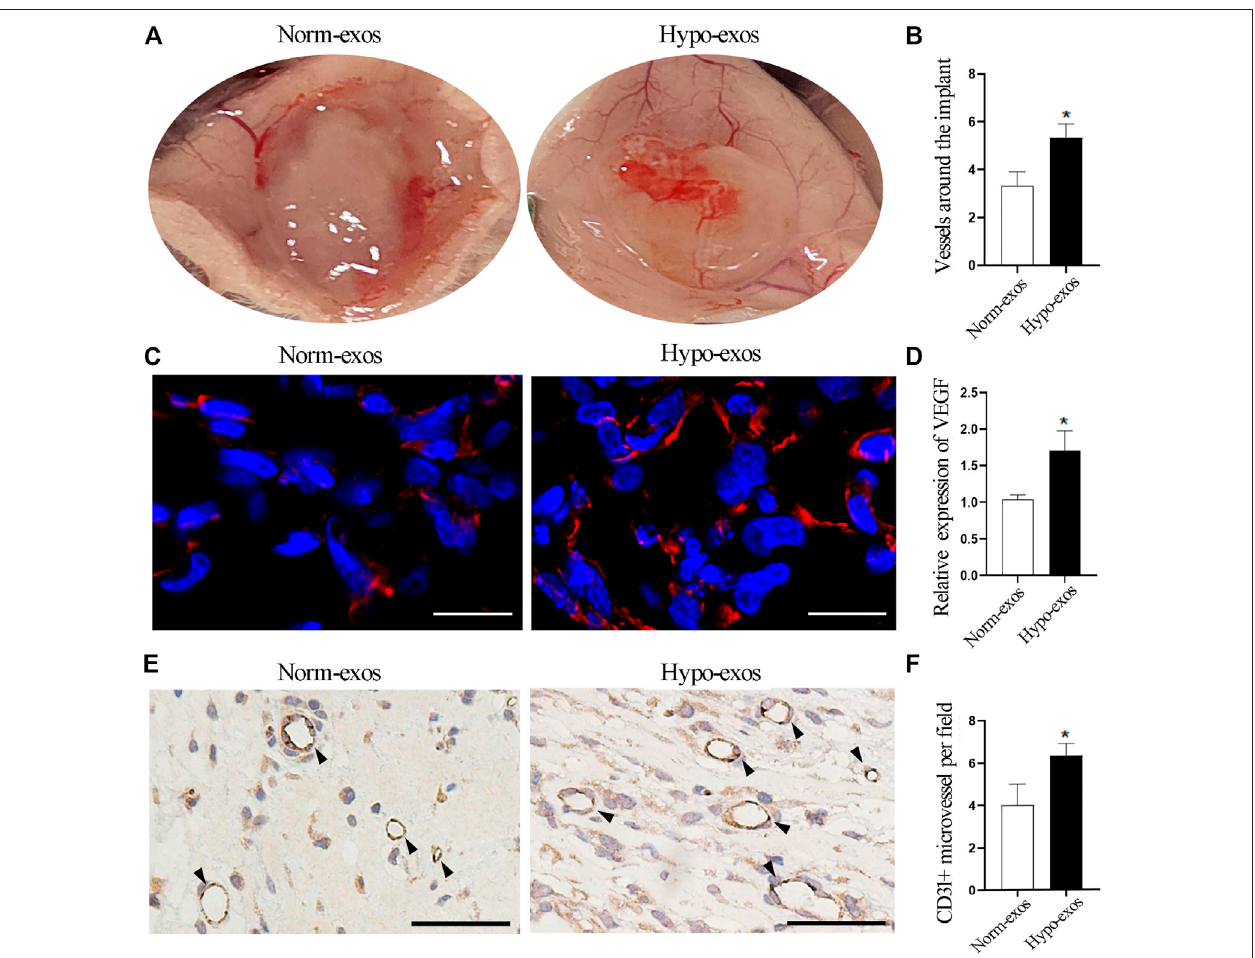
FIGURE4| Hypo-exospromotemicro-vesselformation invivo comparedwithNorm-exos. (A) RepresentativeimagesofMatrigelplugsimplantedsubcutaneously in mice for 10 days. (B) Quanti fi cation of the number of micro-vessels around the plug implants. (C) Immuno fl uorescence staining for VEGF in implanted matrigel plugs containing Hypo-exos or Norm-exos. Scale bars = 500 μ m. (D) Quanti fi cation of VEGF expression in Matrigel plugs. (E) Increased neovasculature in matrigel plugs containing Hypo-exos visualized by immuno fl uorescence staining of CD31; scale bars = 500 μ m. (F) Quanti fi cation of the number of tubular structures stained by CD31. * p <